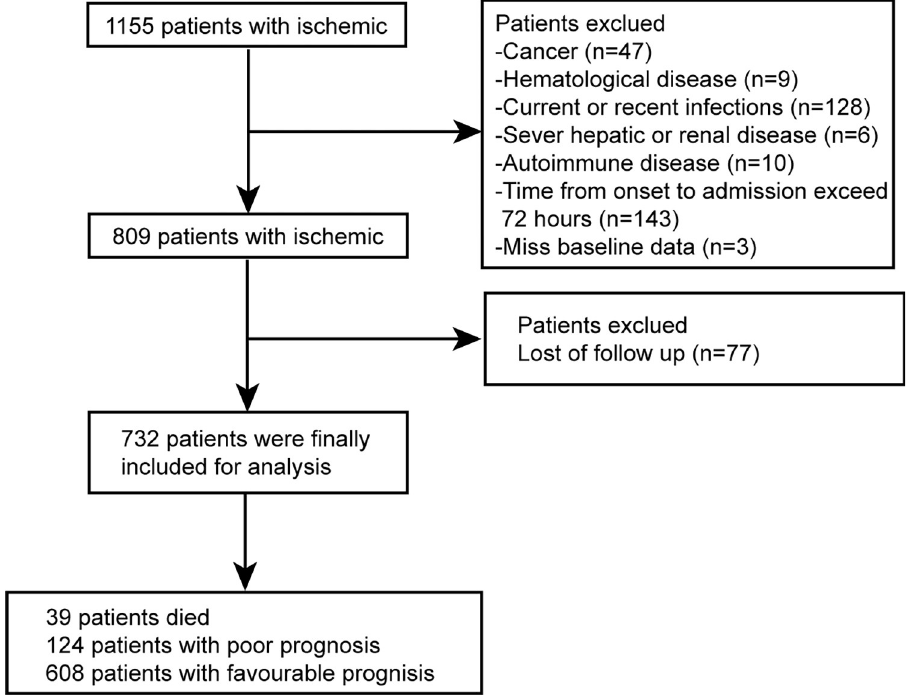
Fig 1. Flow chart of patient enrollment in this